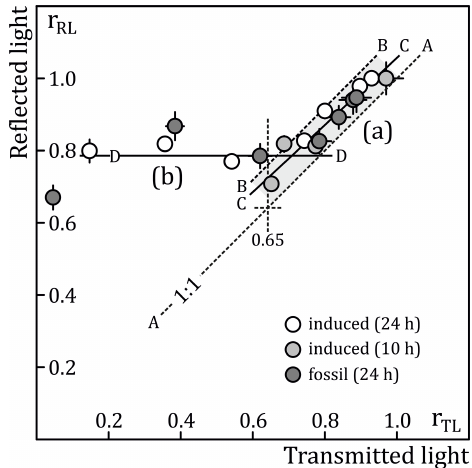
Figure 7. Normalized fossil and induced track densities in prism faces of Durango apatite determined using reflected light ( r RL ) plotted against those measured in the same counting areas using transmitted light ( r TL ). The samples were annealed under differ- ent temperature–time conditions, summarized in Table 2, polished to a final high finish with 0.04µm silica suspension and etched for 20s in 5.5M HNO 3 at 21 ◦ C. The induced track densities are nor- malized to those of the unannealed samples and those of the fos- sil tracks to 0 . 89 × that of the unannealed sample, to account for natural annealing. A–A: theoretical relationship for an observation threshold z = 0µm; B–B: theoretical relationship for z = 1µm; C– C: geometric mean regression line to the data before the break in slope (a; 0 . 65 ≤ r TL ≤ 1); D–D: mean r RL value of the data past the break in slope (b; r TL ≤ 0 .